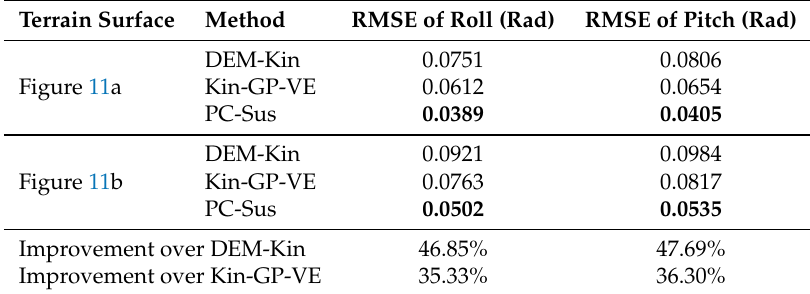
Figure 11. The virtual terrain surfaces used to test the proposed pose estimation method. Table 3. The errors of the different pose estimation